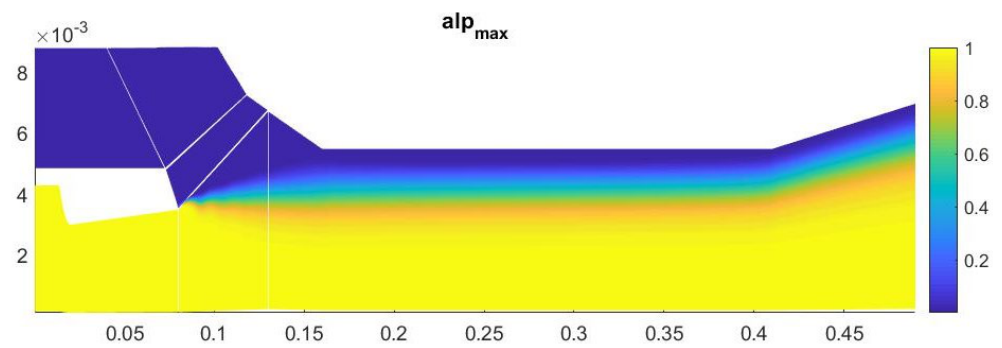
Figure 12. Distribution of the mass fraction of the condensable substance.